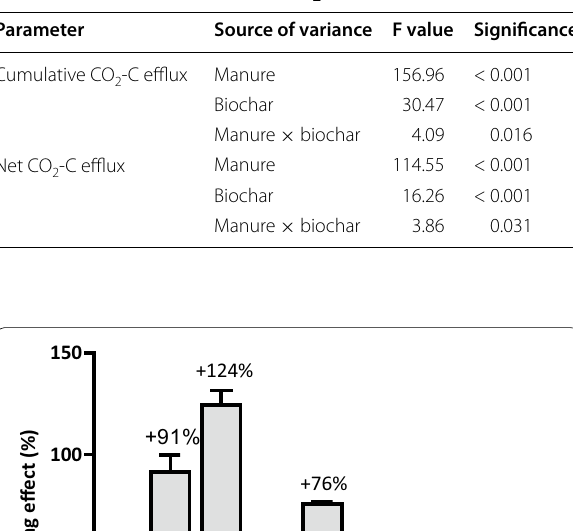
Table 3 Summary of analysis of variance of treatment effect on cumulative and net CO